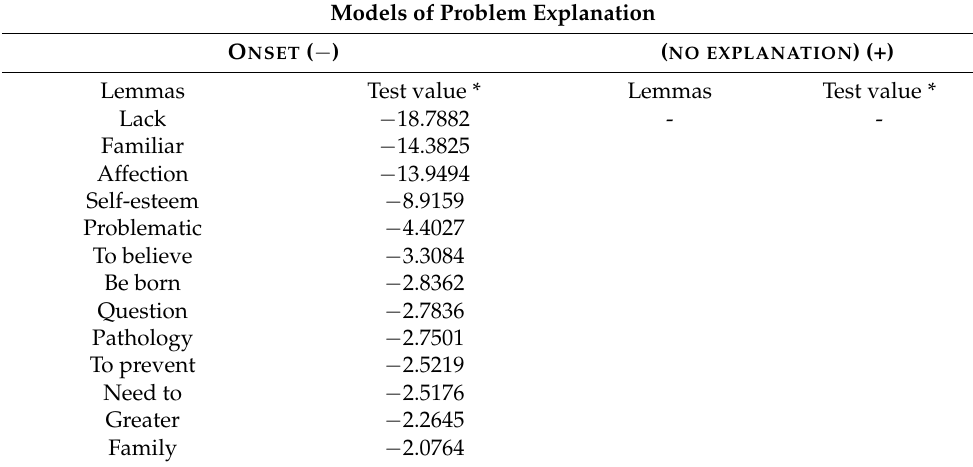
Table 3. First Factorial